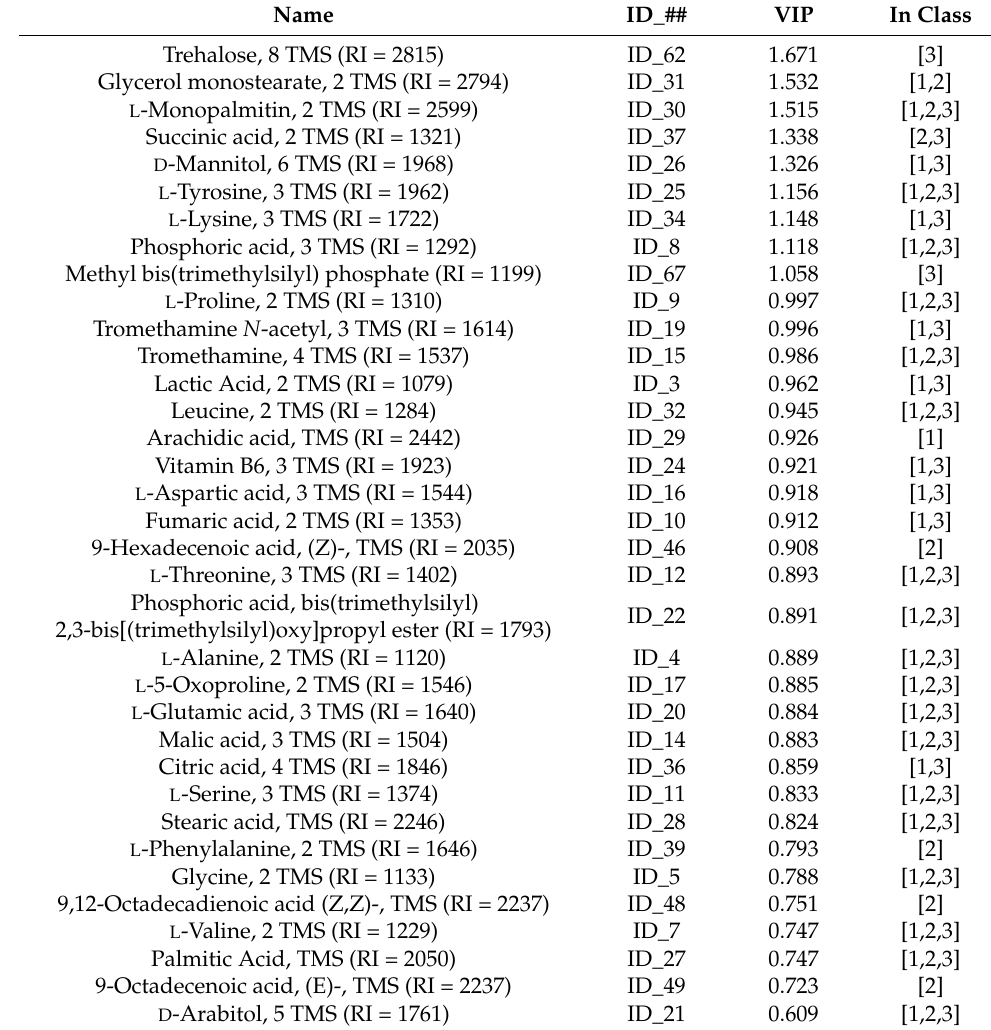
Table 1. Results of multiclass PLS-DA analysis in Figure